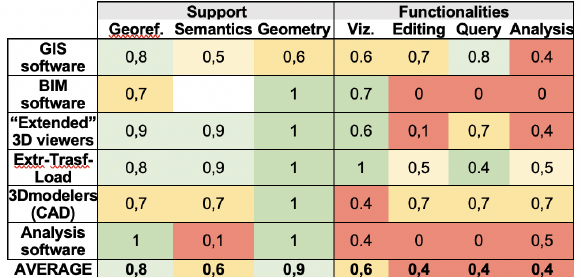
Figure 4. Synthesis table of the delivered tests regarding support for CityGML (benchmark Task 2). The color scale green to red is assigned according to the scores from 1-full support to 0-no support.